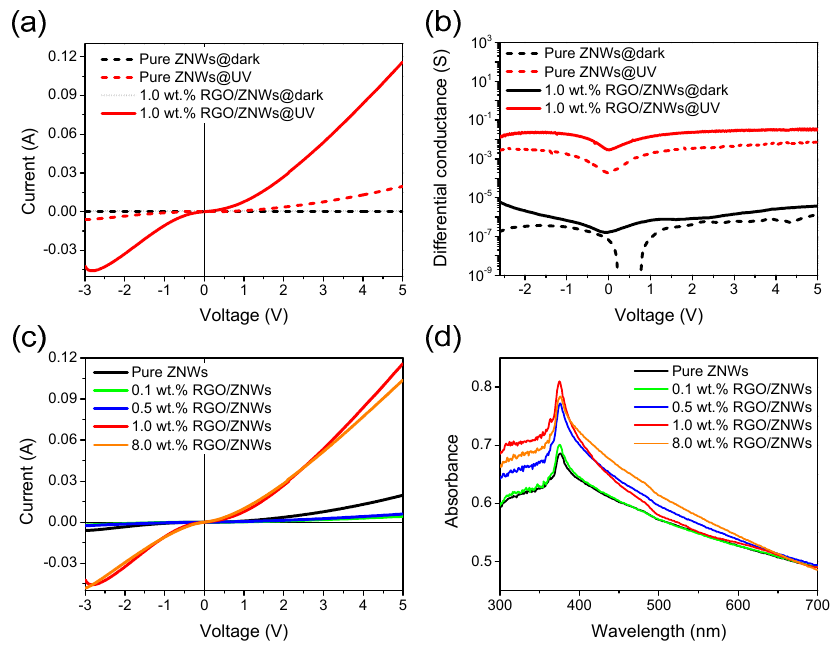
Figure 3. ( a ) I-V curves and ( b ) differential conductance curves of photodetectors based on pure ZNWs and 1.0 wt % RGO/ZNWs composite in dark and under ultraviolet (UV) irradiation with power density of 2.90 mW·cm − 2 ; ( c ) I - V curves of photodetectors based on pure ZNWs and different RGO contents of RGO/ZNWs composites under UV irradiation with power density of 2.90 mW·cm − 2 ; ( d ) Ultraviolet-visible light (UV-VIS) absorption spectra of pure ZNWs and different RGO contents of RGO/ZNWs composites.